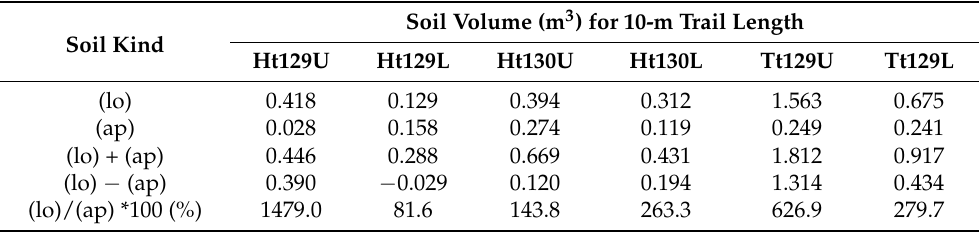
Table 7. Volume of soil applied, moved, and stripped from the trail after skidding. Soil Volume (m 3 ) for 10-m Trail Length Soil Kind